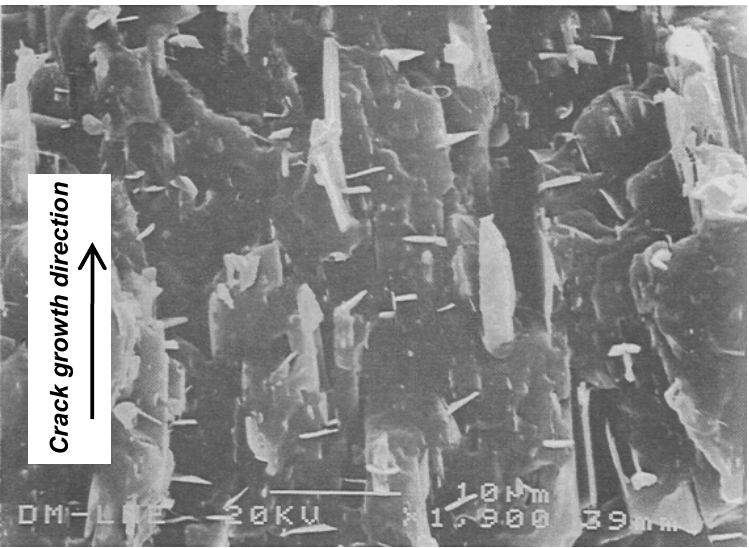
Figure 26. Scanning electron micrograph of a 40 wt.% PP-talc composite, showing the orientation of talc platelets (adapted from